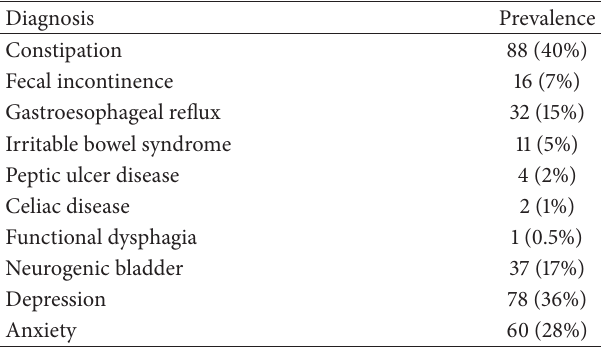
Table 2: Prevalence of self-reported comorbidities in the study